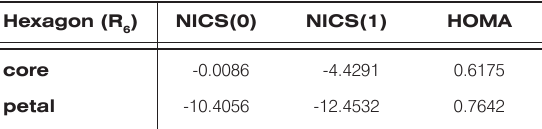
Table 2. The NICS(0), NICS(1) and HOMA values calculated for the B3LYP/6-31G(d) optimized geometry of coronene. Hexagon (R ) 6